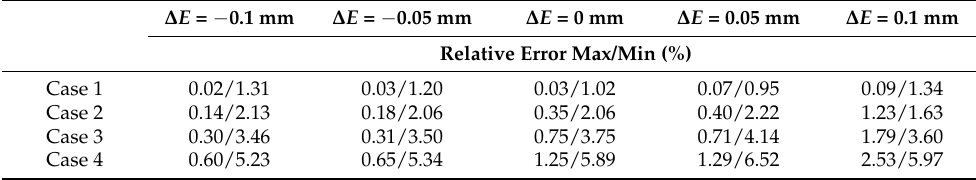
Table 8. The max/min relative differences of TVMS under various crack degrees and offset errors.